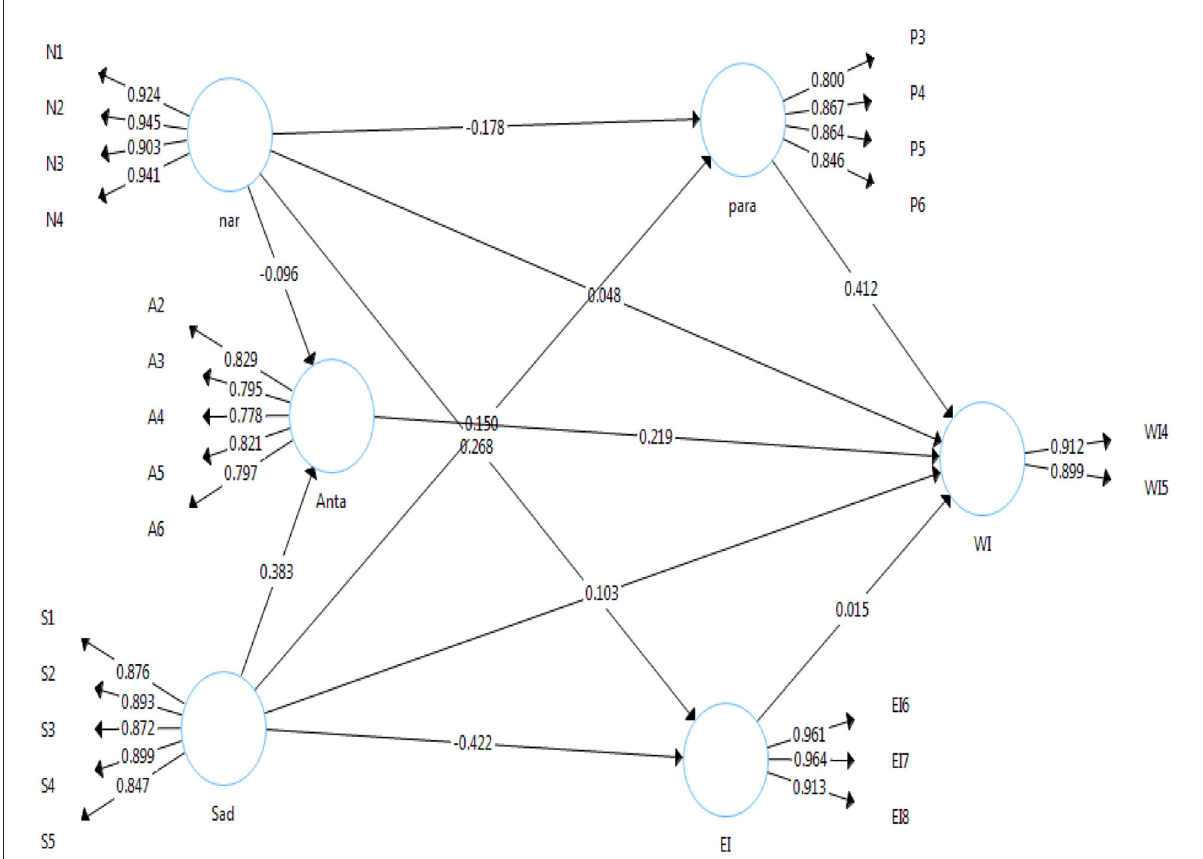
FIGURE2 Measurement Model CFA